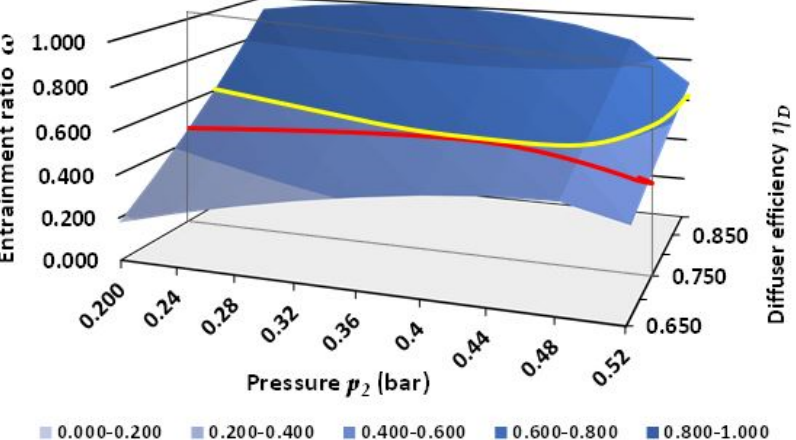
Figure 4. Diagram (derived from Equation (10)) of the entrainment ratio of an ejector (N. 1, Table 1) vs. pressure at the exit of the suction chamber p 2 and the diffuser efficiency η D : ω = f ( p 2 , η D ) . The red curve represents the function: ω = f ( p 2 ) . The yellow curve represents the function: η D = f ( p 2 ) . The p 2 pressure value that maximizes the entrainment ratio ω is also the one that minimizes the diffuser efficiency η D .